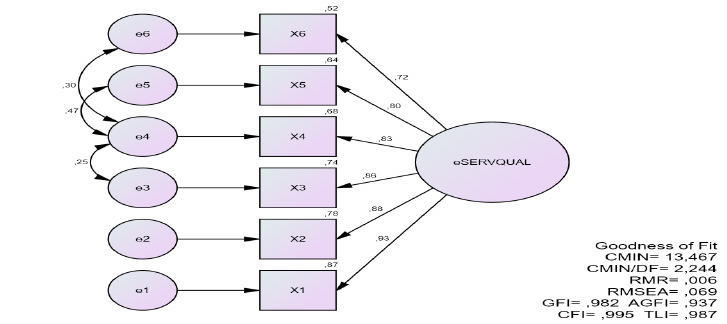
Fig. 2. Reconstruction of dimensions of E-Service